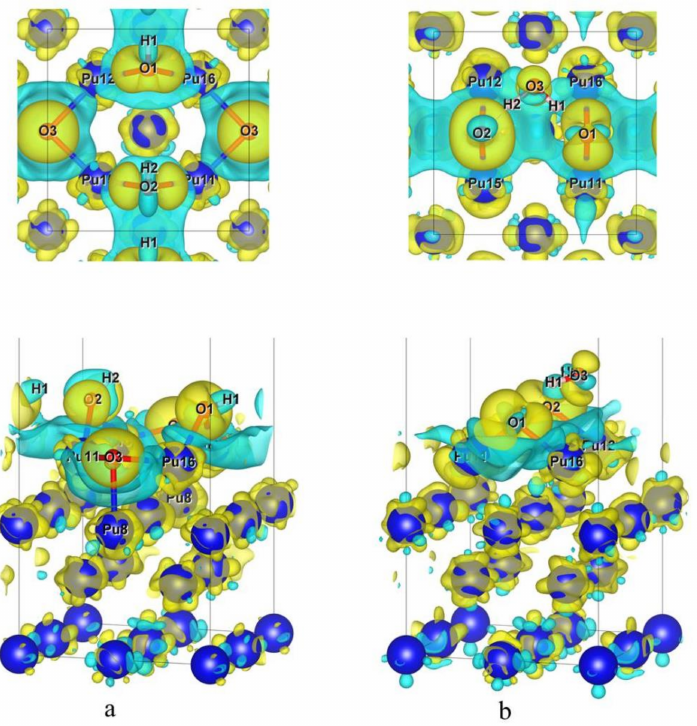
Figure 10. ( a ) Differential charge density diagram of BH-S-H4O10; ( b ) differential charge density diagram of B-S-H2O4 (electron density isosurface is 0.0035 e/Å 3 , yellow indicates an increase in charge density, while blue-green indicates a decrease in charge density; the top is a top view and the bottom is a perspective